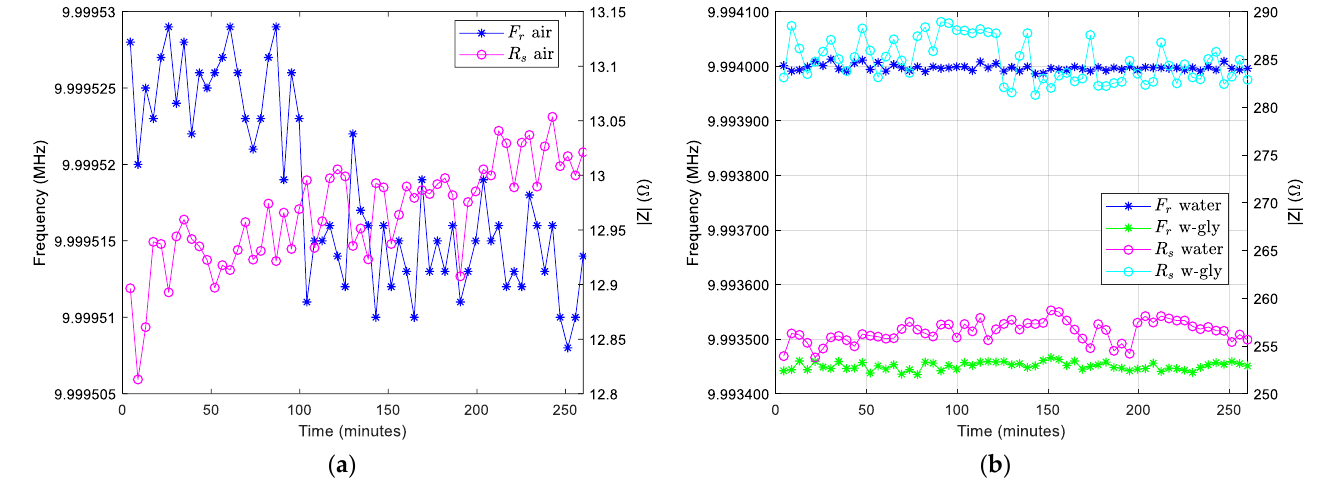
Figure 11. ( a ) In the air: evolution of the resonant frequency at minimum impedance ( 𝐹 𝑟 ) and minimum impedance ( 𝑅 𝑠 ). ( b ) In water and 20% glycerol – water solution: evolution of the resonant frequency at minimum impedance ( 𝐹 𝑟 ) and minimum impedance ( 𝑅 𝑠 ).